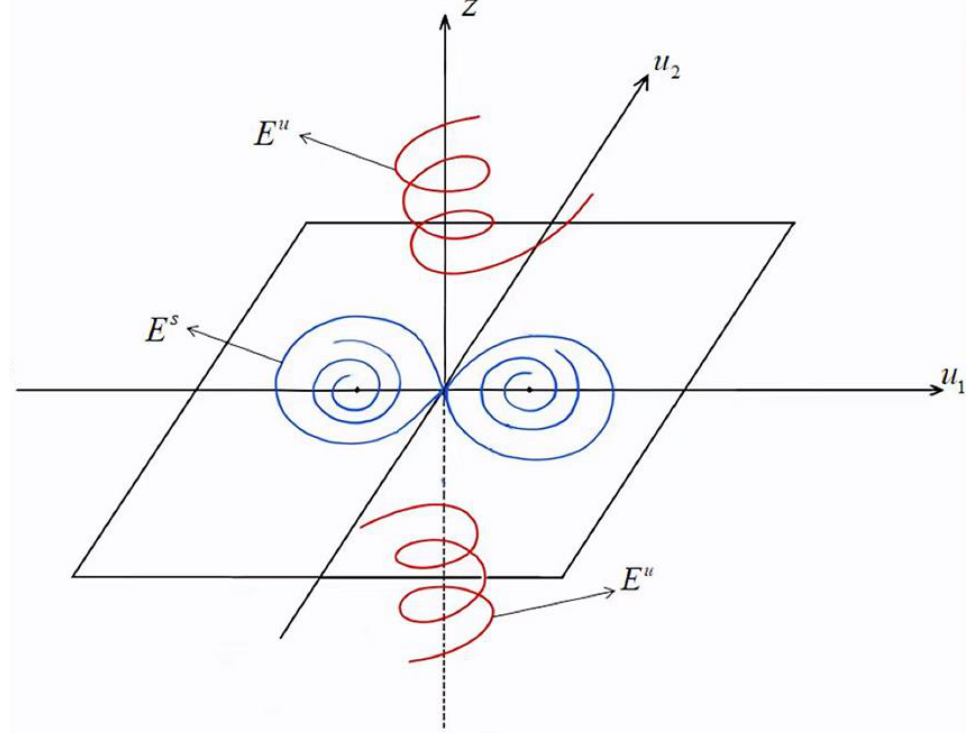
Figure 1. The geometric structures of stable and unstable manifolds.